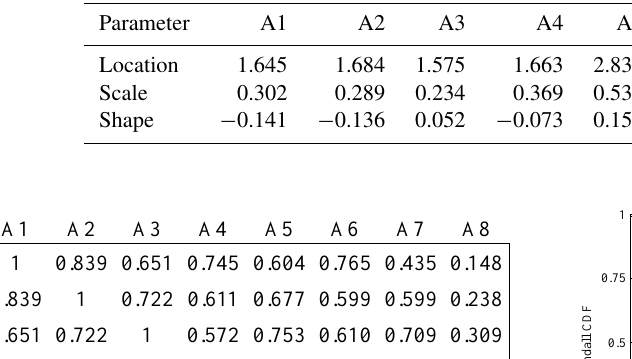
Table 4. Parameters of the GNO distribution of precipitation of sub-regions and the entire region.